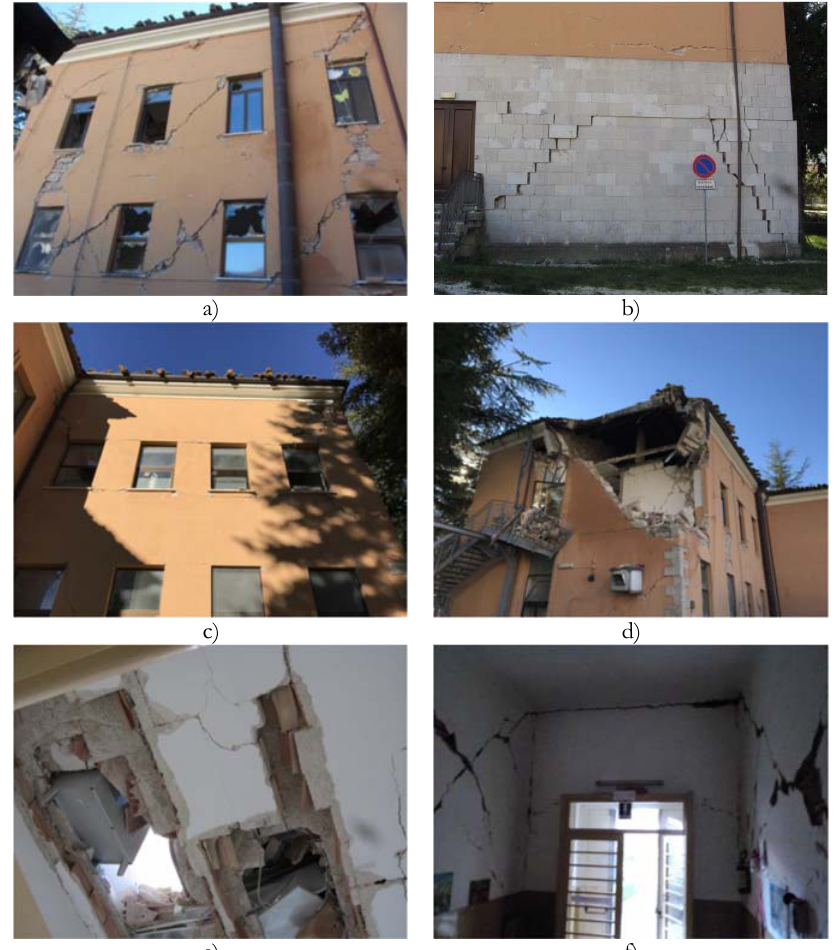
Figure 4: Damage state updated on December 8 th , 2016: a) diagonal shear cracks in piers and spandrels, b) shear-sliding mechanism, c) flexural cracks, d) out-of-plane mechanism, e) local collapse of the slab between the raised ground floor and first floor, f) cracks in correspondence of the connection between walls and slabs